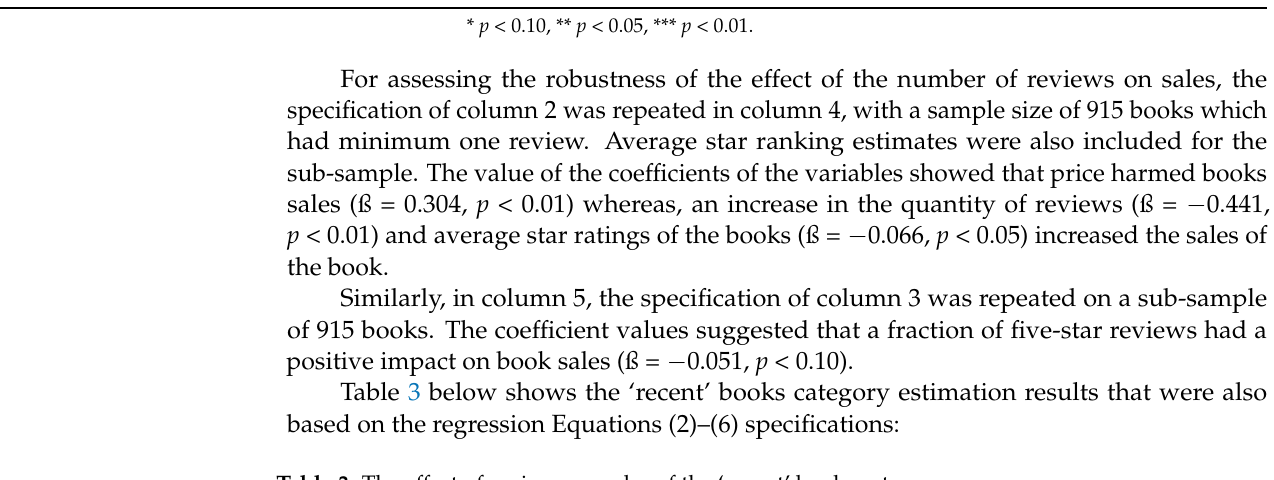
Table 3. The effect of reviews on sales of the ‘recent’ books